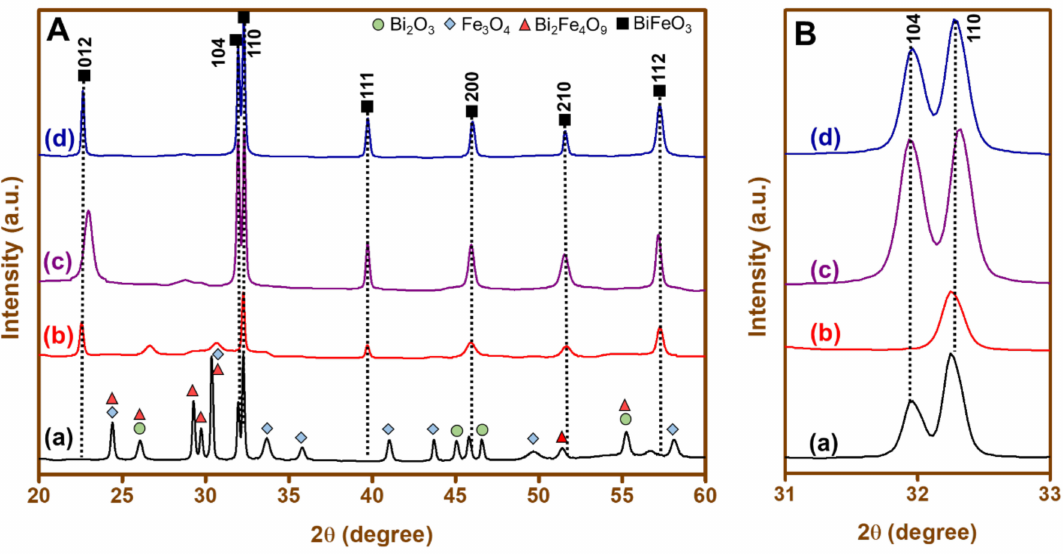
Figure 1. XRD pattern of ( A ) (a) BFO-C, (b) BFO-S, (c) BFO-L, and (d) BFO-M nanoparticles; ( B ) en- larged 2 θ portion between 31 ◦ and 33 ◦ .